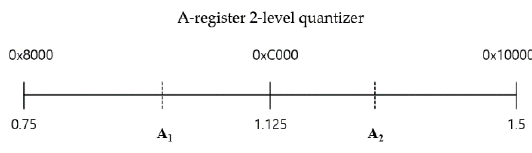
Table 4. Adjusting the α and β values, the compression ratio is expected to change.